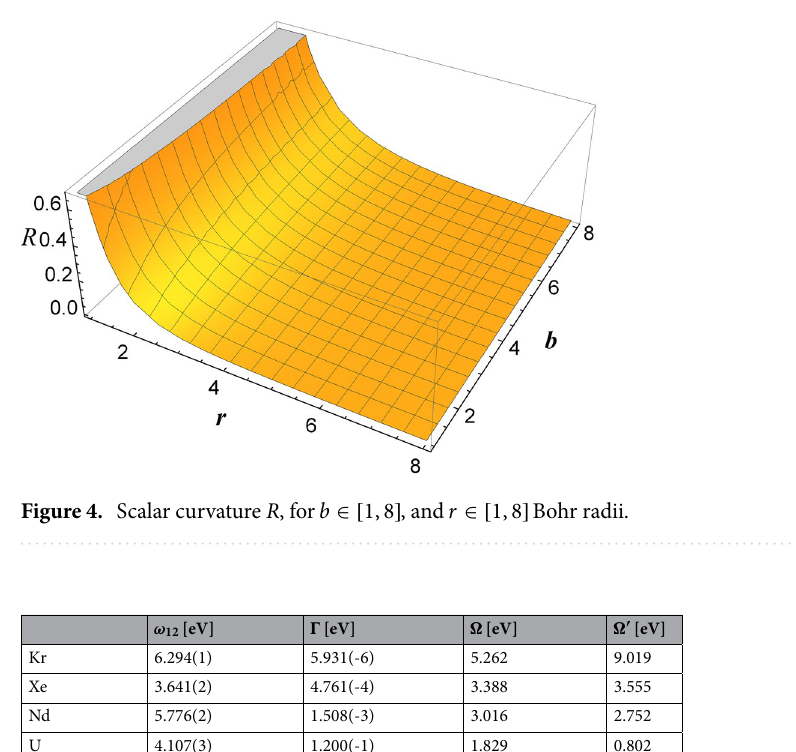
Table 1. Parameters for the 2 s width Ŵ , and Rabi frequencies (cid:31) are given for the laser intensities I